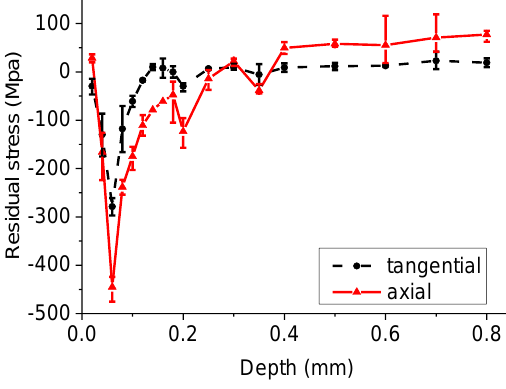
Figure 12. Machining-induced residual stress.